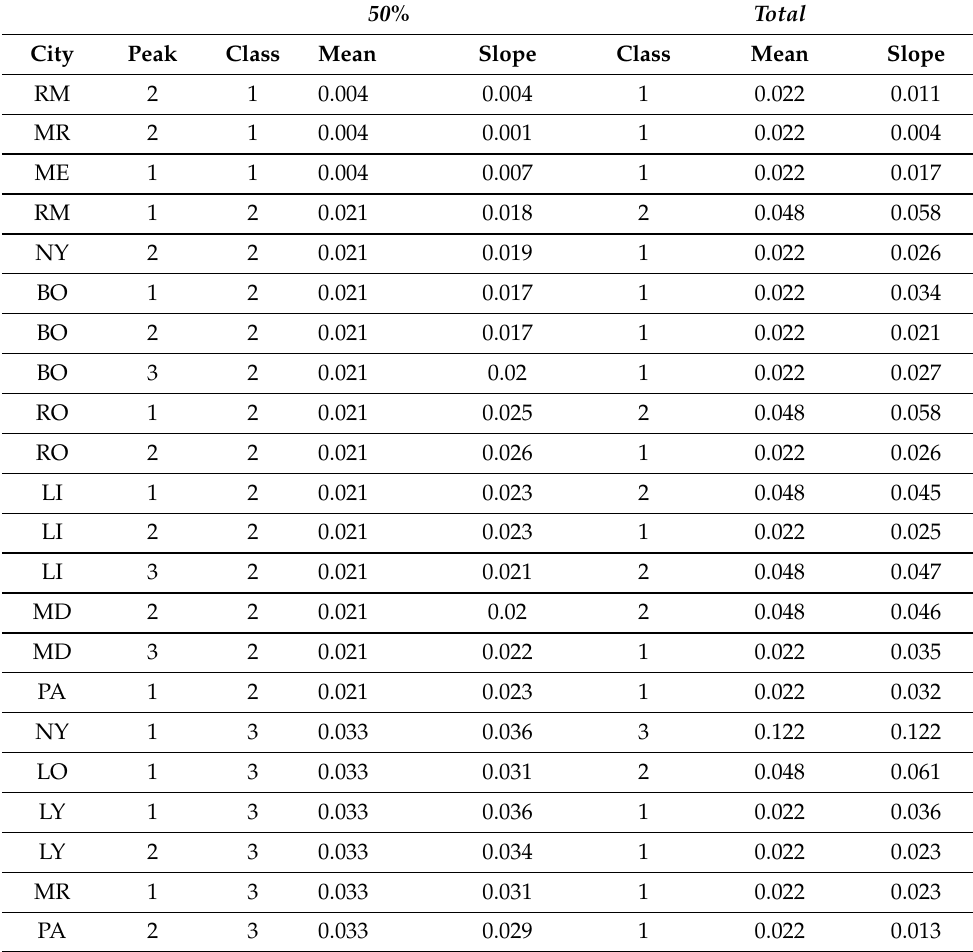
Table 6. Cluster analysis for rises at total and 50 %, without the first rise of